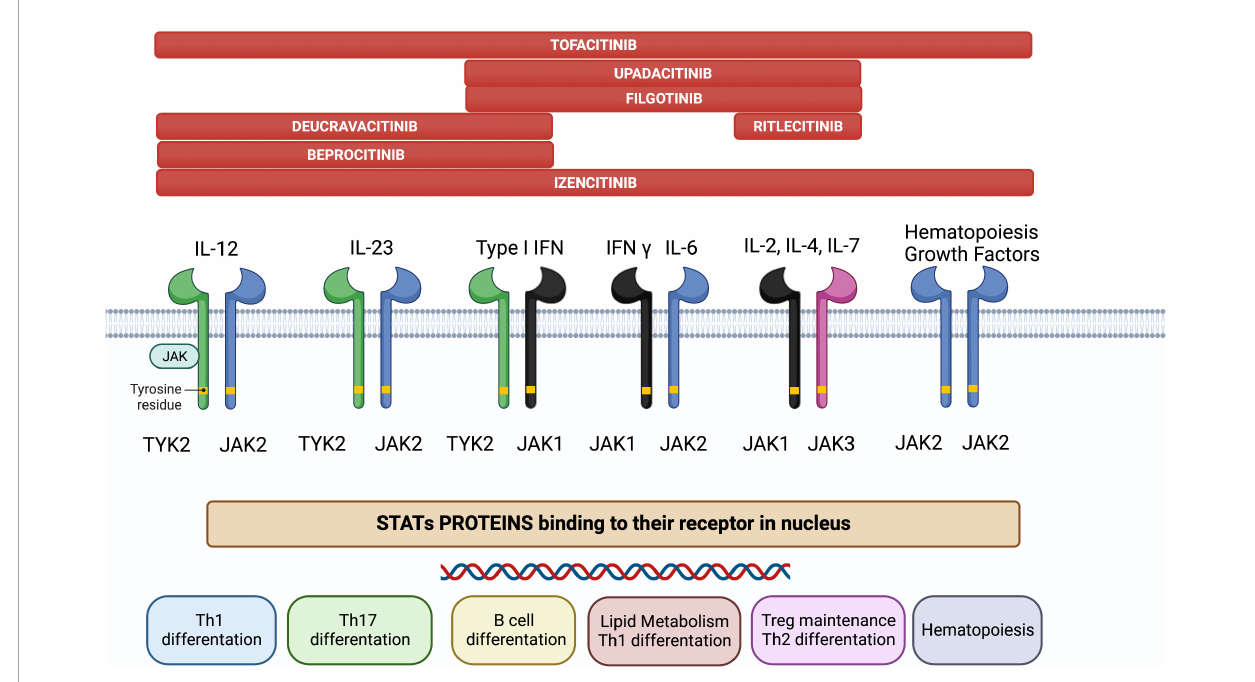
FIGURE1 The JAK/STAT pathway constitutes a membrane-to-nucleus signaling module and induces the expression of various mediators of inflammation. Shown above are the different JAK inhibitors and their selectivity for different membrane JAK receptor subtypes; the immunological pathways inhibited by each receptor and their biological effects are shown below.